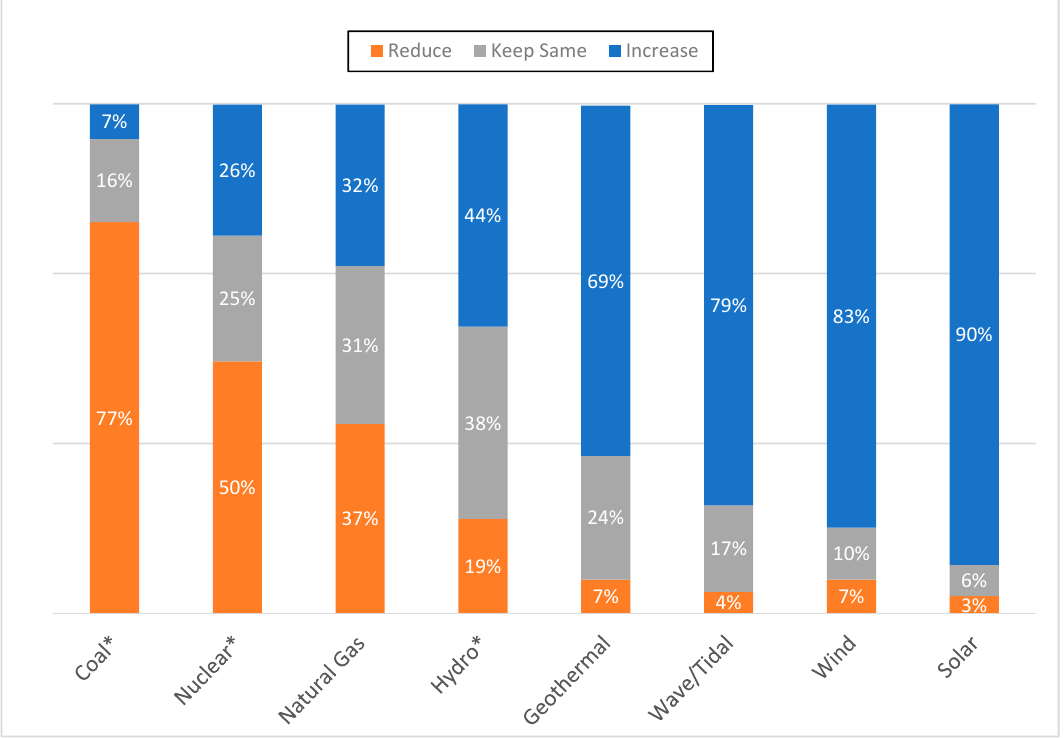
Figure 2. Respondent preferences for eight energy sources, ordered from the least to most preferred (n = 1500). * Indicates significant state/province differences in support (p < 0.001). Respondents in BC were more opposed to coal and nuclear than those in OR and WA. Respondents in OR were more opposed to hydropower than those in WA and BC.